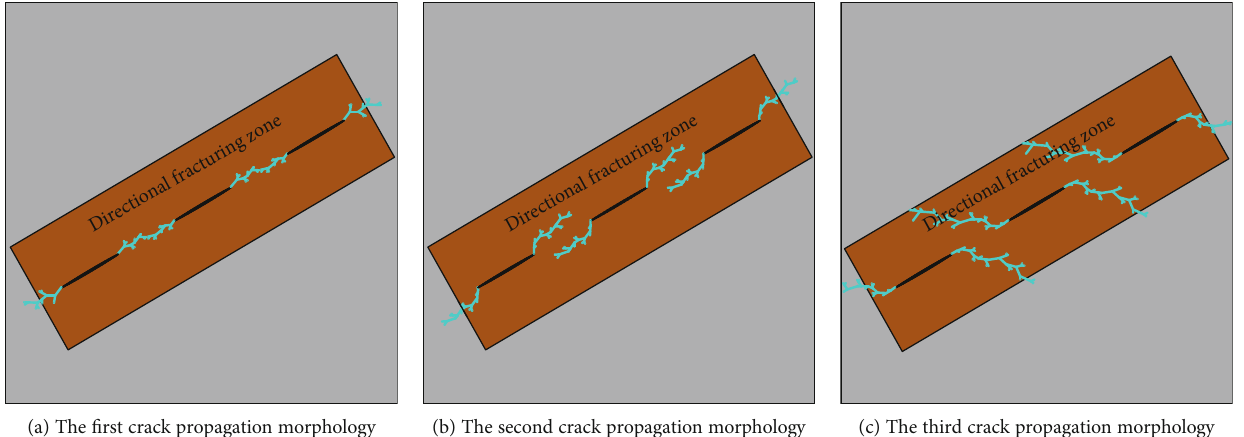
Figure 9: Three types of directional hydraulic fracturing (DHF) crack propagation